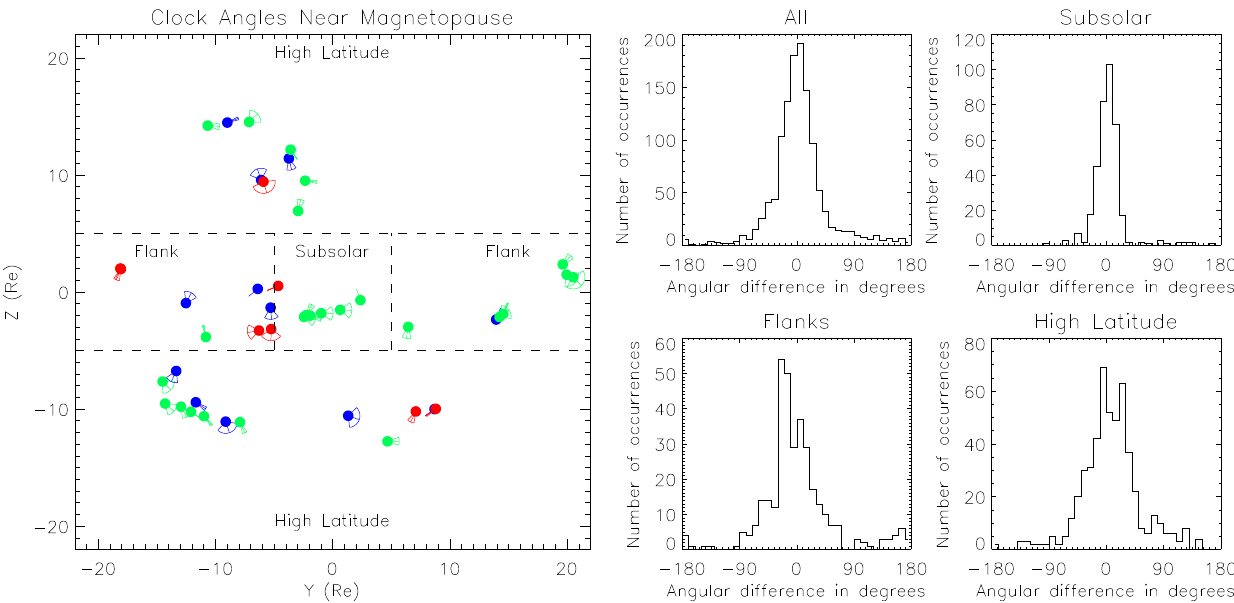
Fig. 3. Clock angles measured near magnetopause, and angular differences from perfect draping, for smoothed data (five-minute boxcar filter). Format as Fig. 2.